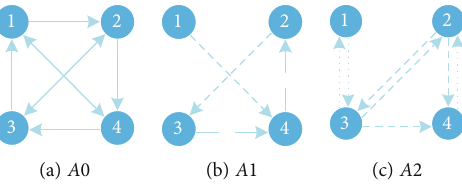
Figure 2: Topology of the multilink complex networks in Example 1 with four nodes and three